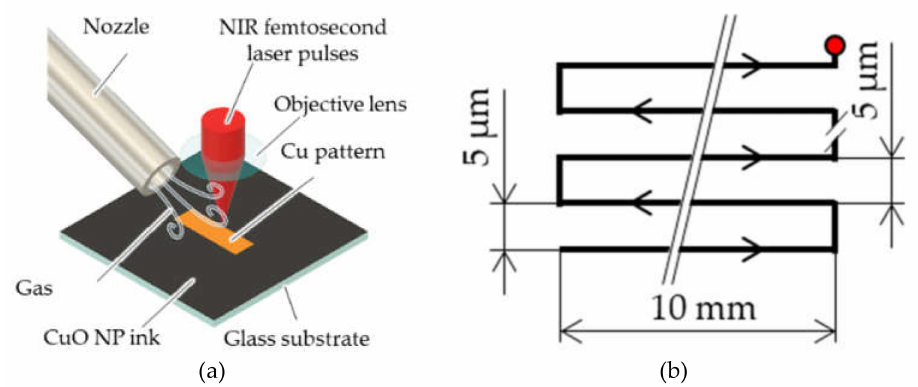
Figure 1. Schematic illustration of Cu patterning under a controlled atmosphere: ( a ) laser patterning and ( b ) scanning route of the focal spot over the